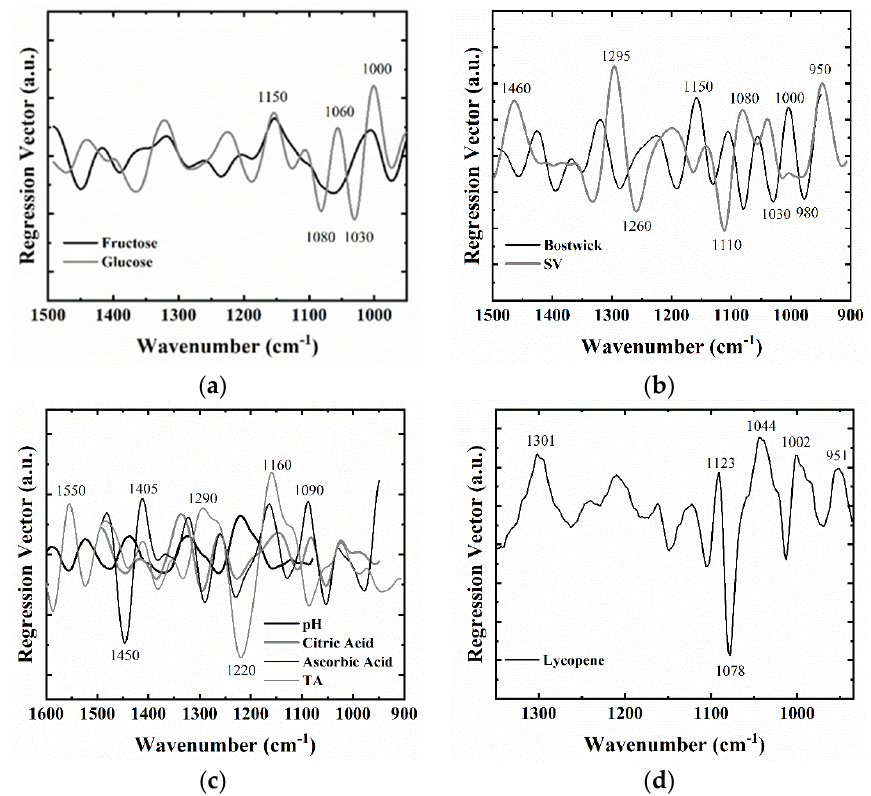
Figure 2. PLSR regression vectors for ( a ) glucose and fructose ( b ) Bostwick consistency and serum viscosity ( c ) titratable acidity, pH, citric acid, and ascorbic acid ( d ) lycopene.